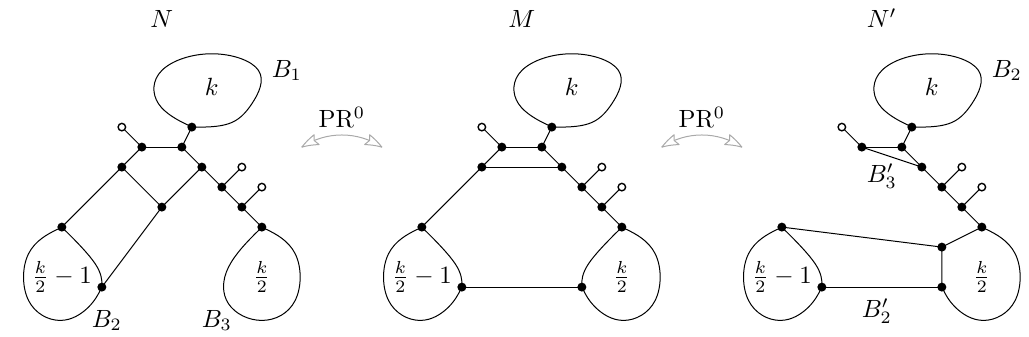
Figure 17: For even k , a PR 0 -sequence from a level- k network N to a level- k network N (cid:48) (hidden reticulations of the blob-parts given inside, at least two leaves ommited: in B and in B ). However, the network M in the middle is a level- ( k + 1) but not a level- k 3